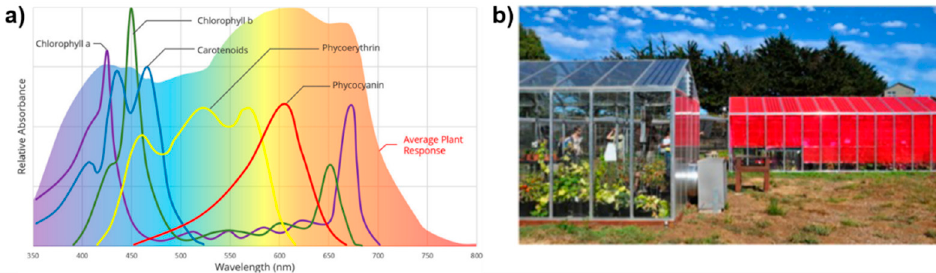
Figure 5 . ( a ) The McCree curve, representing the average photosynthetic response of plants at each wavelength, and the absorption curves of different pigments in plants. Reprinted with permission from Ref. [49]. Copyright 2022 American Chemical Society. ( b ) Greenhouse prototypes, one covered with clear glass (left) and one covered with LSC thin film devices (right). Reprinted with permission from Ref. [56]. Copyright 2016 AIP Publishing.